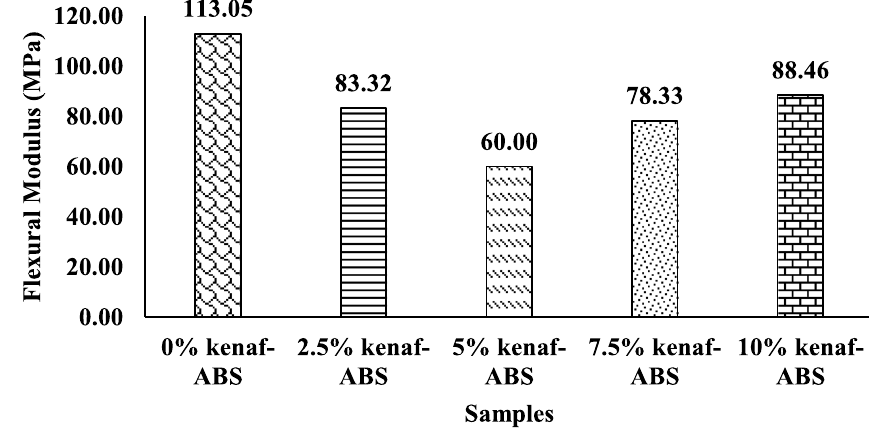
Fig. 8 Flexural modulus for kenaf-ABS composites